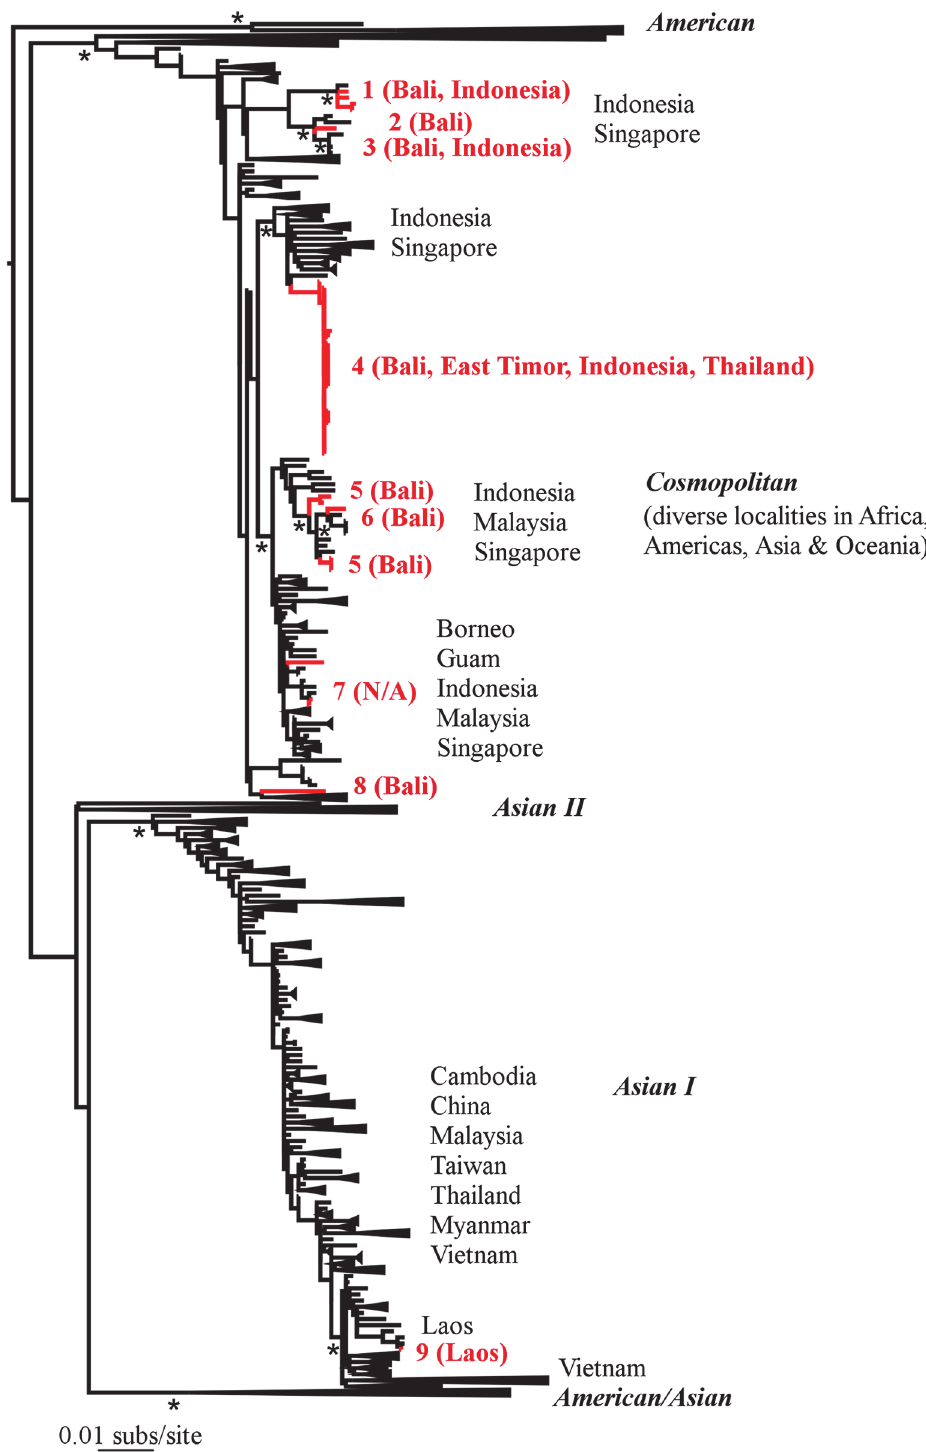
Figure 3. Phylogenetic tree of 2263 DENV-2 E sequences including 46 from travellers to Australia. Other features are as they are described in Fig. 2.